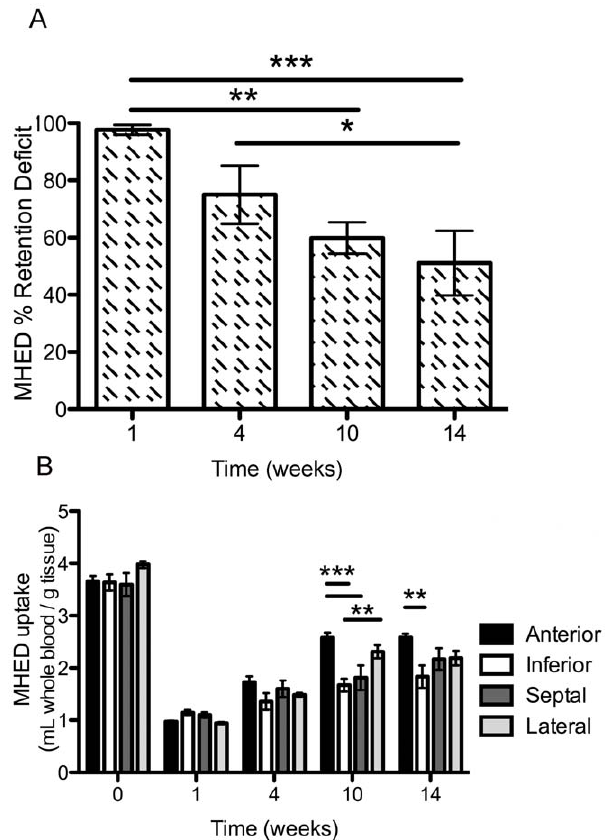
Figure 4. Quantitative analysis of MHED PET. A, Group mean global MHED % retention deficit comparing 1, 4, 10, and 14 weeks after toxin to baseline. B, Group mean regional MHED uptake comparing anterior, inferior, septal, and lateral regions of the left ventricle at baseline and at 1, 4, 10, and 14 weeks after toxin. * P , 0.05, ** P , 0.01, *** P ,